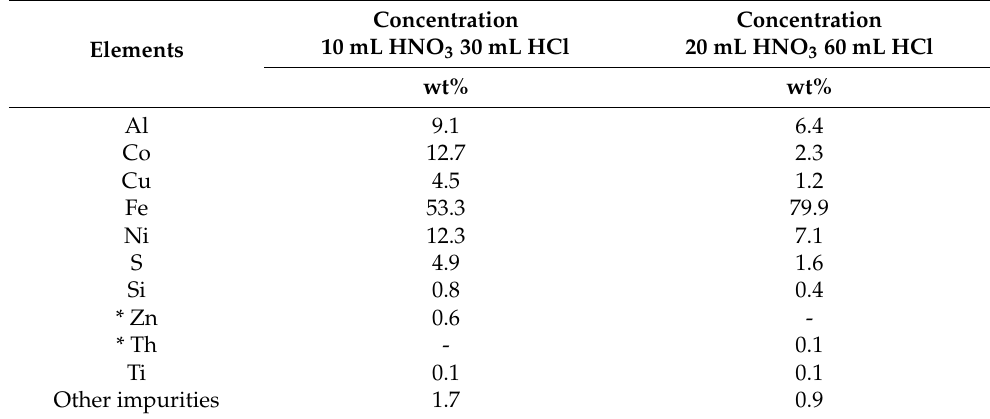
Table 3. Elemental analysis of the ilmenite ore by ICP-OES (wt%).